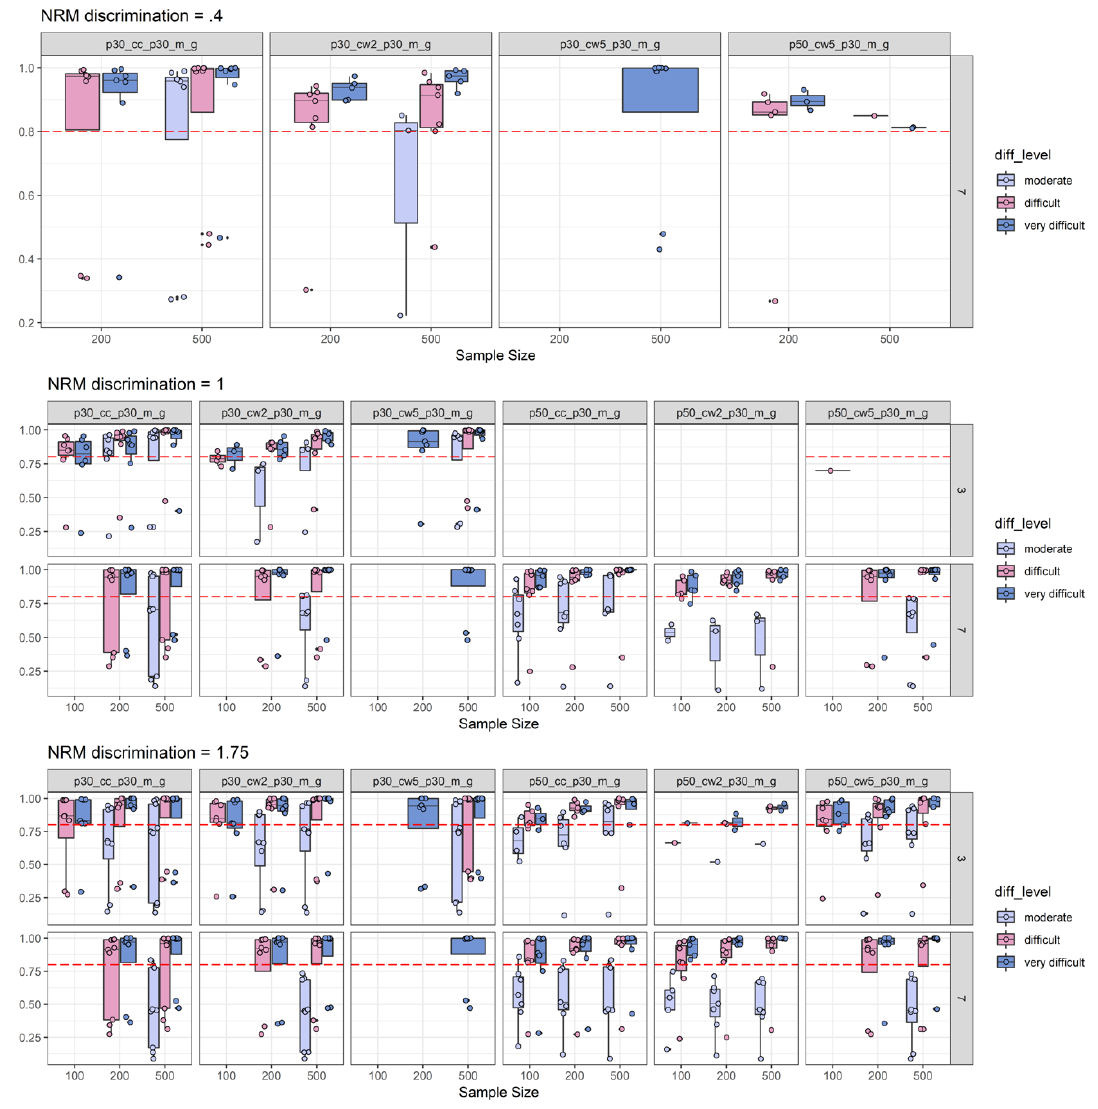
Figure A5. 2PL-difficulty split of empirical power analysis: Depiction of the empirical power (y-axis) under the boundary condition that the average γ is greater than 0.30. Power is depicted as a function of NRM discrimination, sample size (x-axis), number of distractors, 2PL-difficulty, and discrimination effect sizes combined with effect size thresholds. The horizontal red dashed line represents the target power level of 0.80. For more explanations, see Figures 2 and 3.